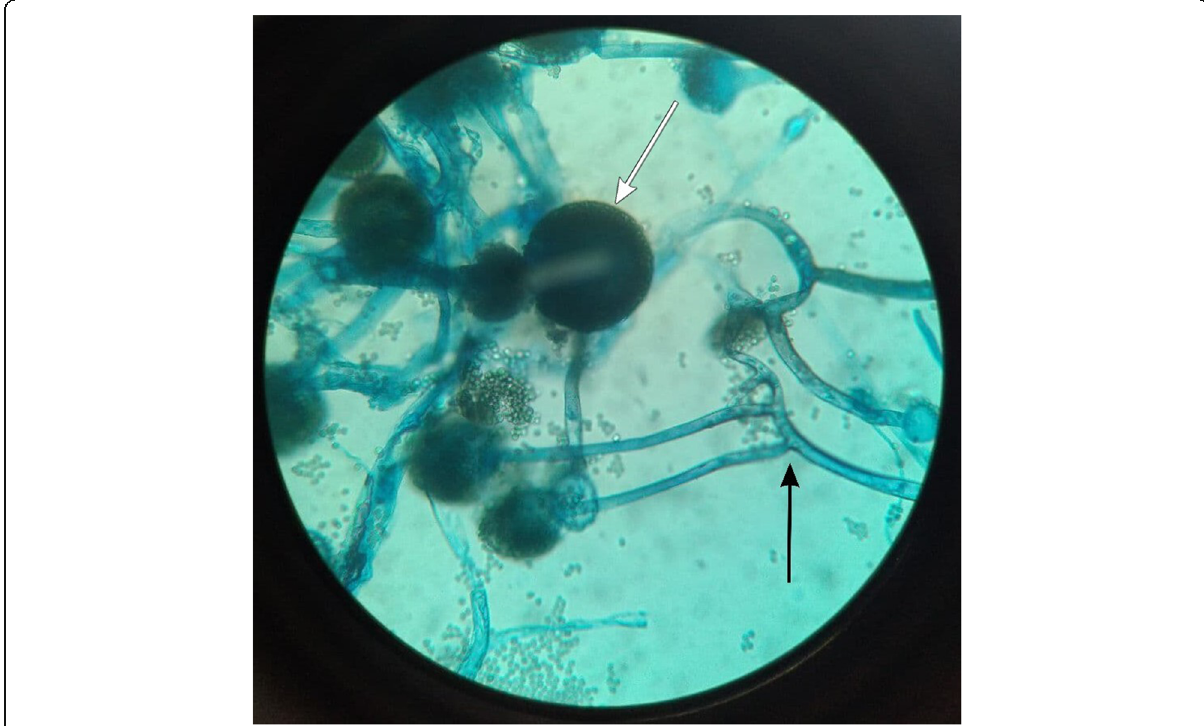
Fig. 2 Lactophenol cotton blue (LPCB) stain after culture on Sabouraud dextrose agar (SDA) showing broad aseptate ribbon-like hyphae branching at right angles (black arrow) with sporangium (white